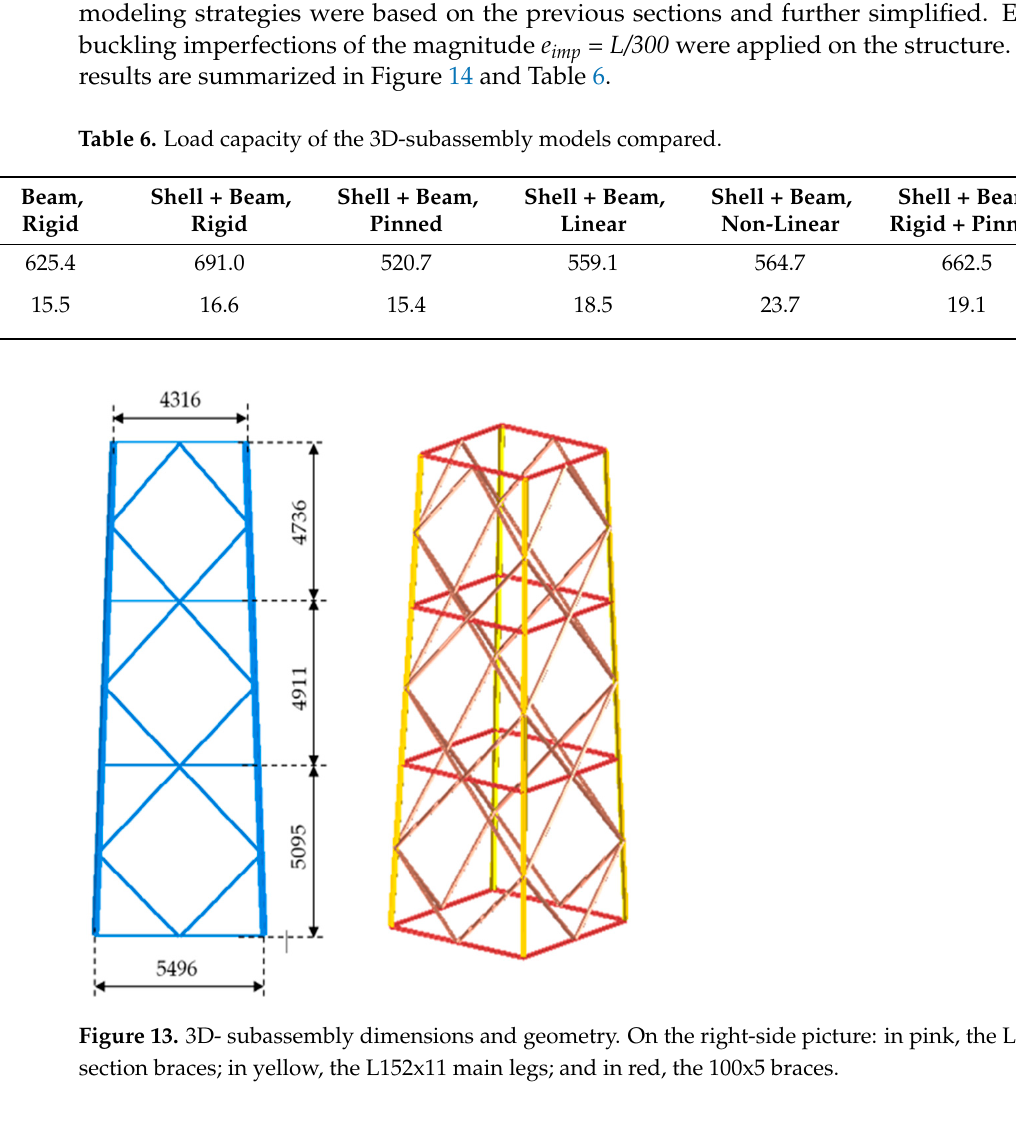
Figure 12. Vertical force–displacement curves of the planar models compared.